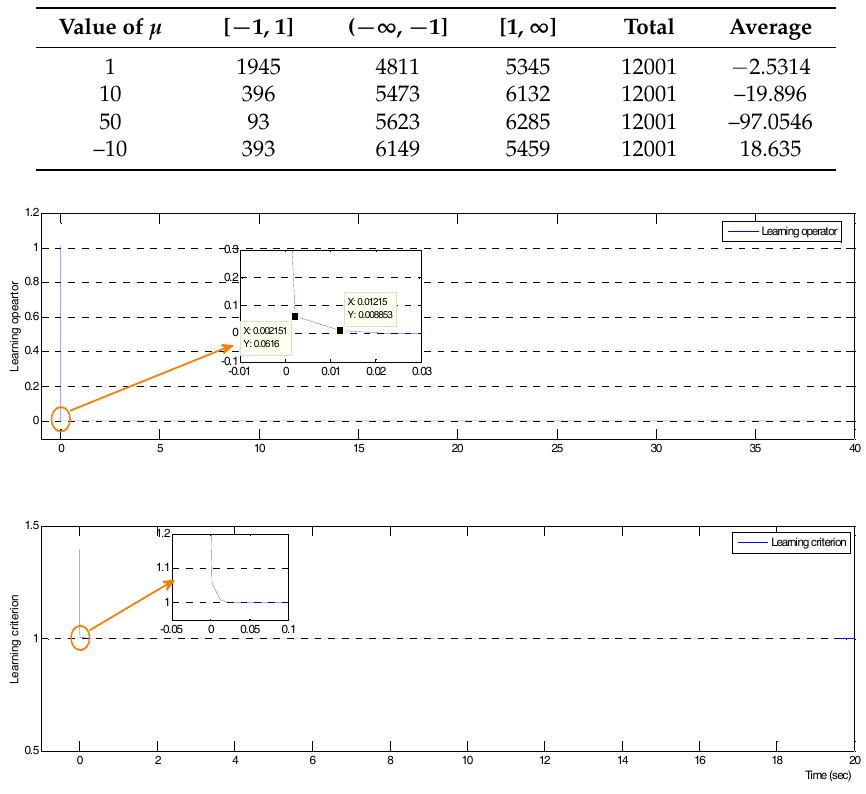
Figure 6. The behavior of the derivative of the Lyapunov function ( μ = 1). Table 1. The Lyapunov function in different interval with different values of μ .